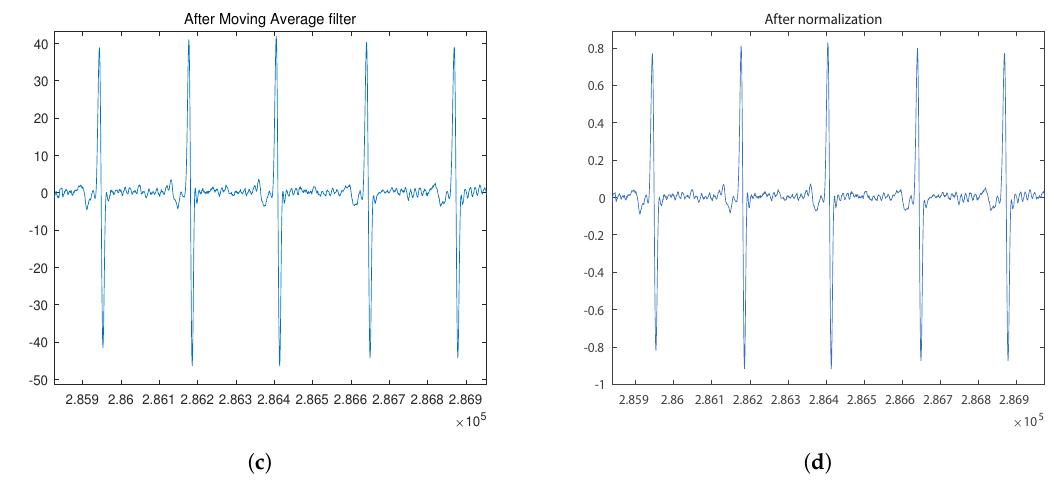
Figure 6. ECG signal preprocessing before the segmentation for input data: ( a ) ECG raw signal; ( b ) signal obtained after derivative filter; ( c ) signal obtained after moving average filter; ( d ) signal obtained after